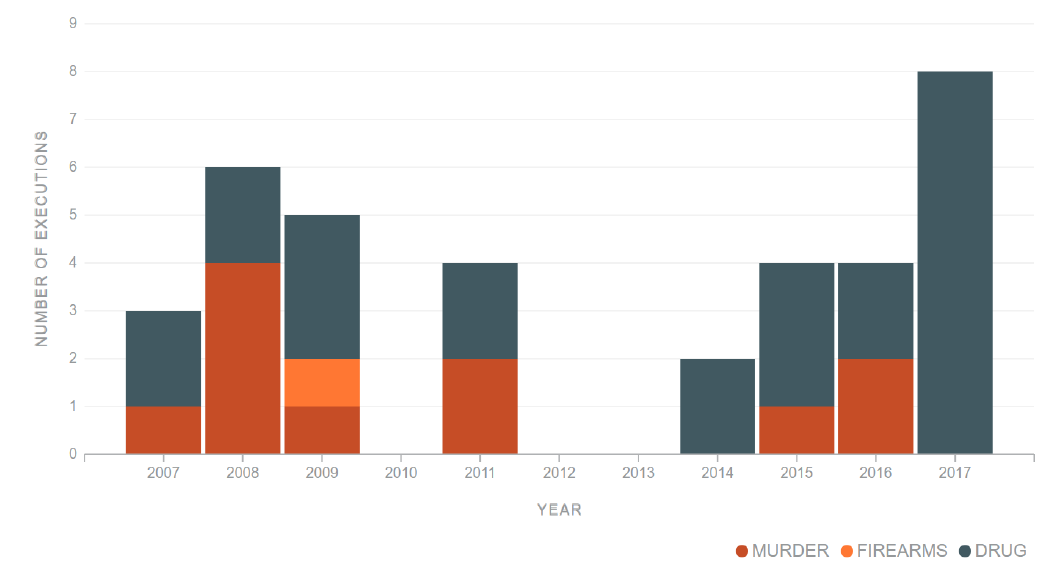
Figure 2: Annual Breakdown of Judicial Executions from 2007 – 2016. Source: Ministry of Home Affairs